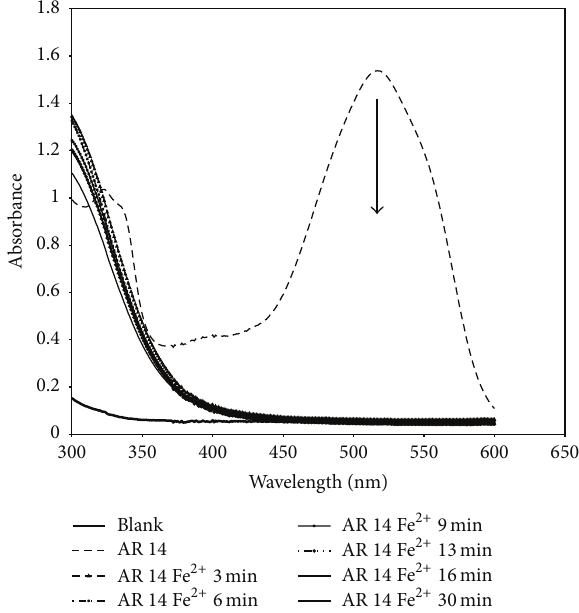
Figure 4: UV-Visible spectra changes of Acid Red 14 during Fenton process (Fe 2+ /H 2 O 2